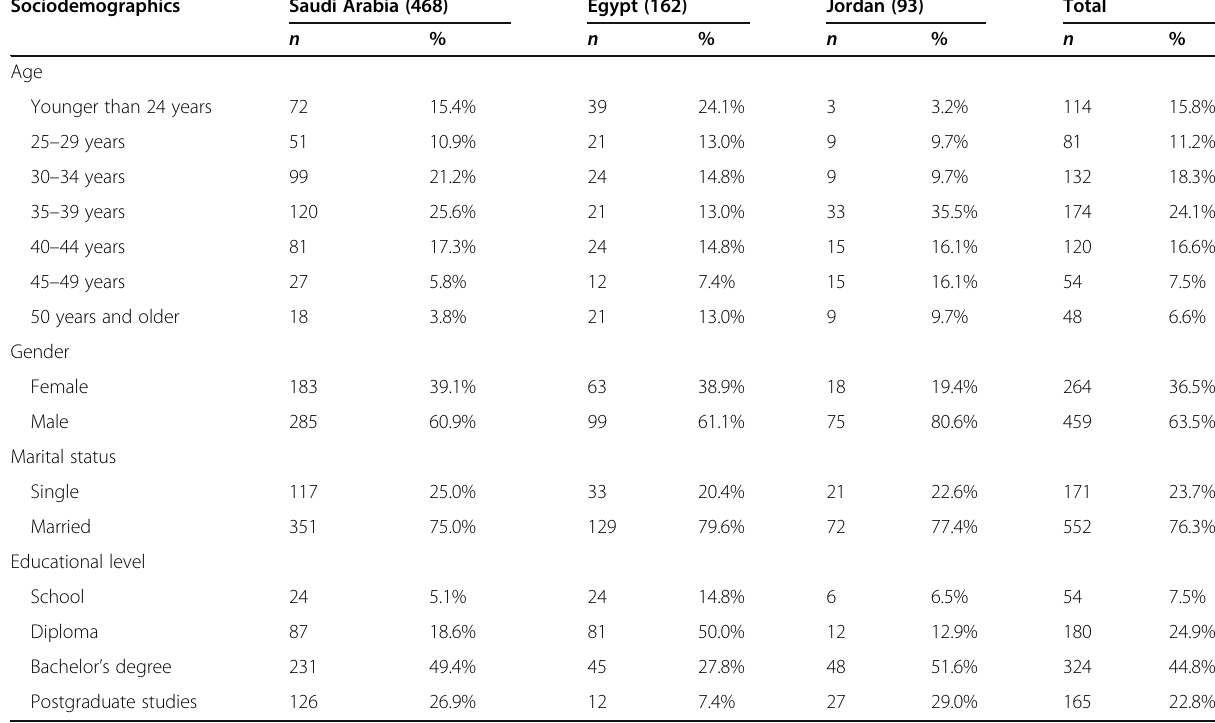
Table 1 Sociodemographic characteristics of the study sample ( N = 723)